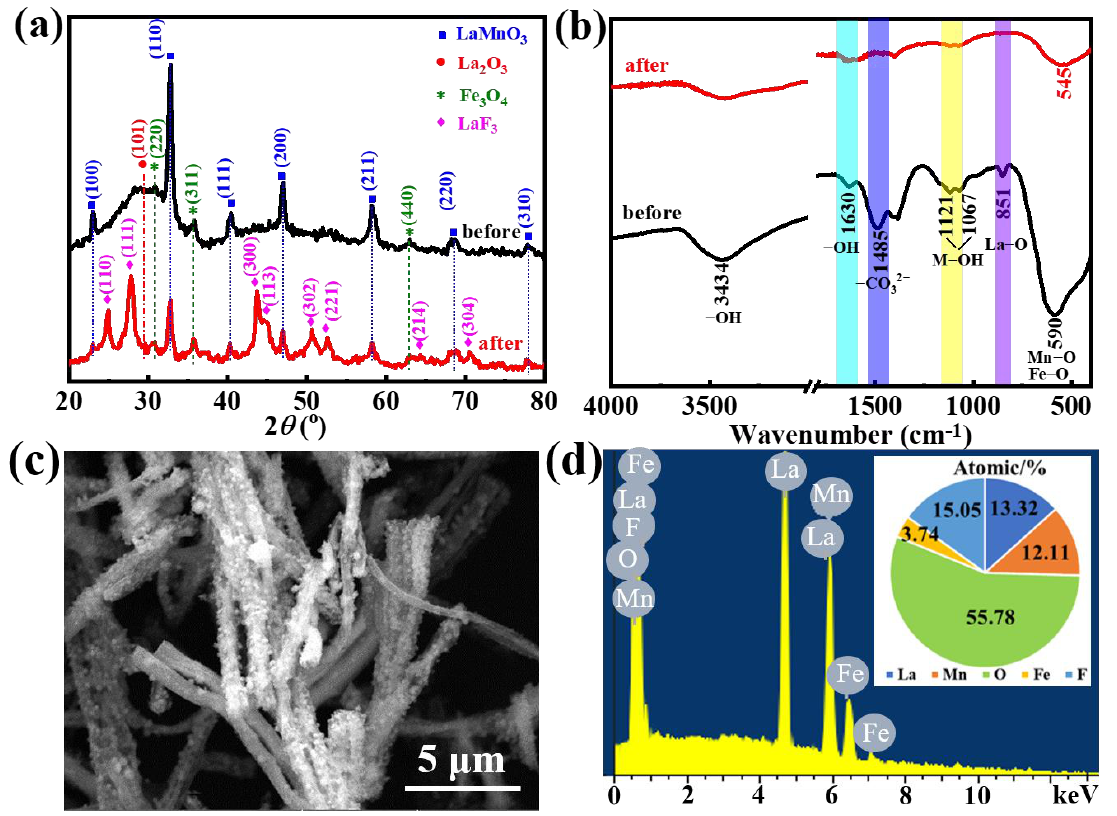
Figure 12. PXRD patterns ( a ) and FTIR spectra ( b ) of LMF11 NFs before and after F − loaded, SEM image ( c ) and EDS ( d ) of LMF11 NFs after F − uptake.